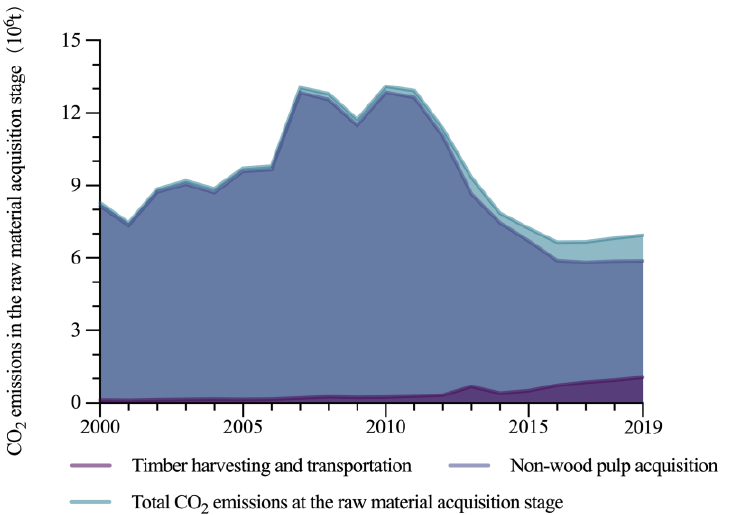
Figure 3. CO 2 emissions from the raw material acquisition